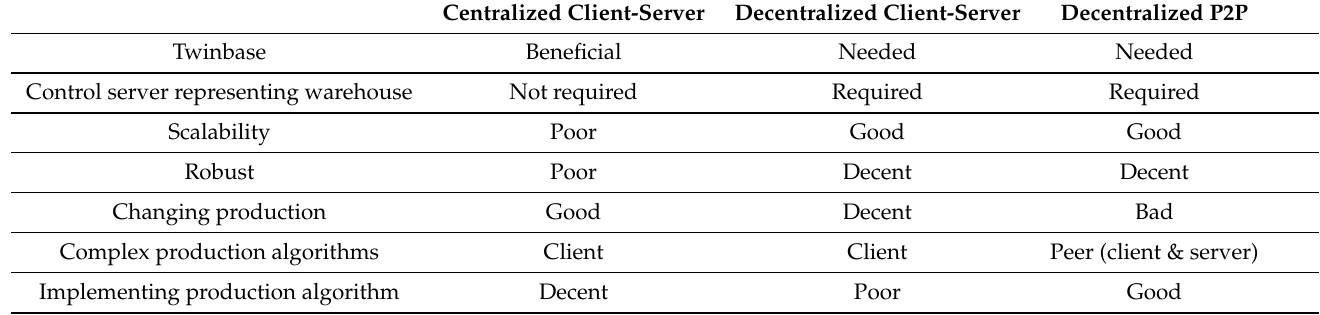
Table 1. Comparison of advantages and disadvantages of different implementations. Adopted from